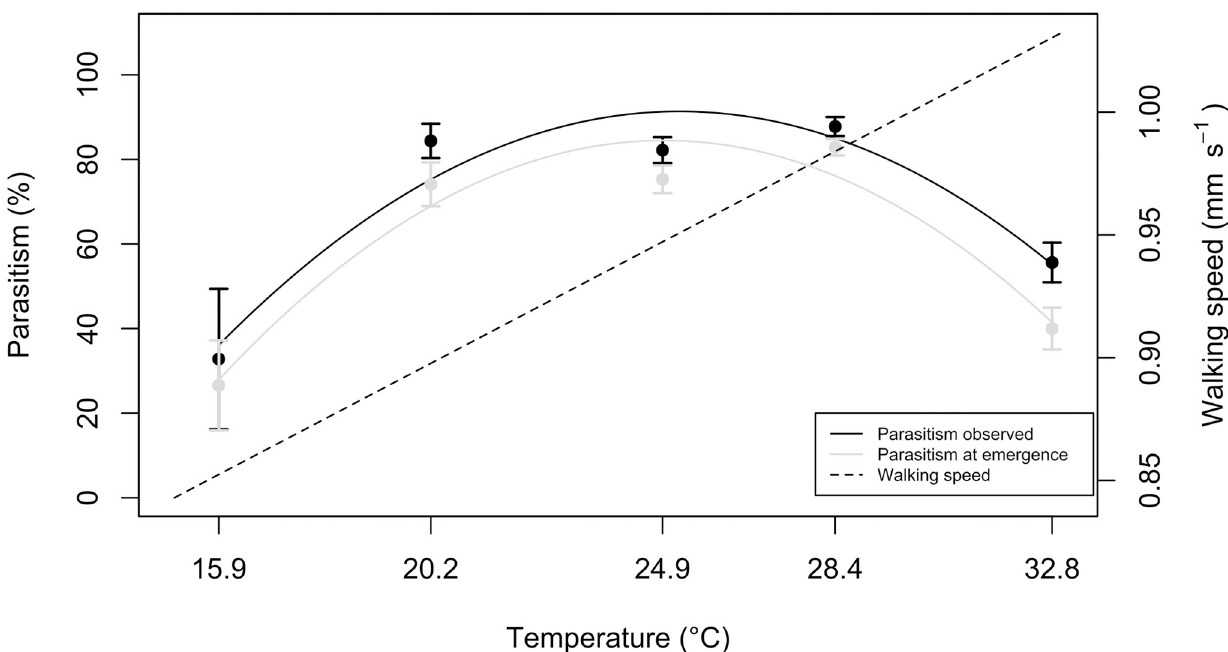
Fig 4. Percentage of Anaphes listronoti parasitism of Listronotus oregonensis eggs ( � X � SE ), calculated from either video sequences (black) or offspring emergence (grey), and walking speed calculated from Eq 1 (see text).